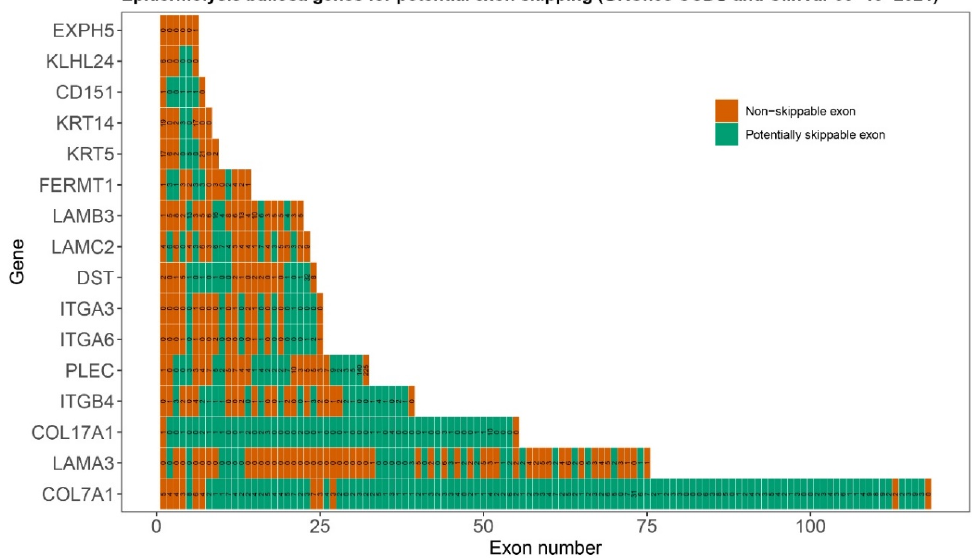
Figure 3. Overview of pathogenic variants per exon for each EB gene. For each EB gene (Y-axis), each exon is shown as a separate tile (not to scale, X-axis). The number of tiles indicates the absolute number of exons per gene. Green tiles represent in-frame and potentially skippable exons, red tiles represent non-skippable (out-of-frame) exons. The number in each tile is the number of pathogenic variants as recorded in ClinVar on 7 October 2021. For this figure, the canonical consensus coding sequences are used as found in Ensembl.